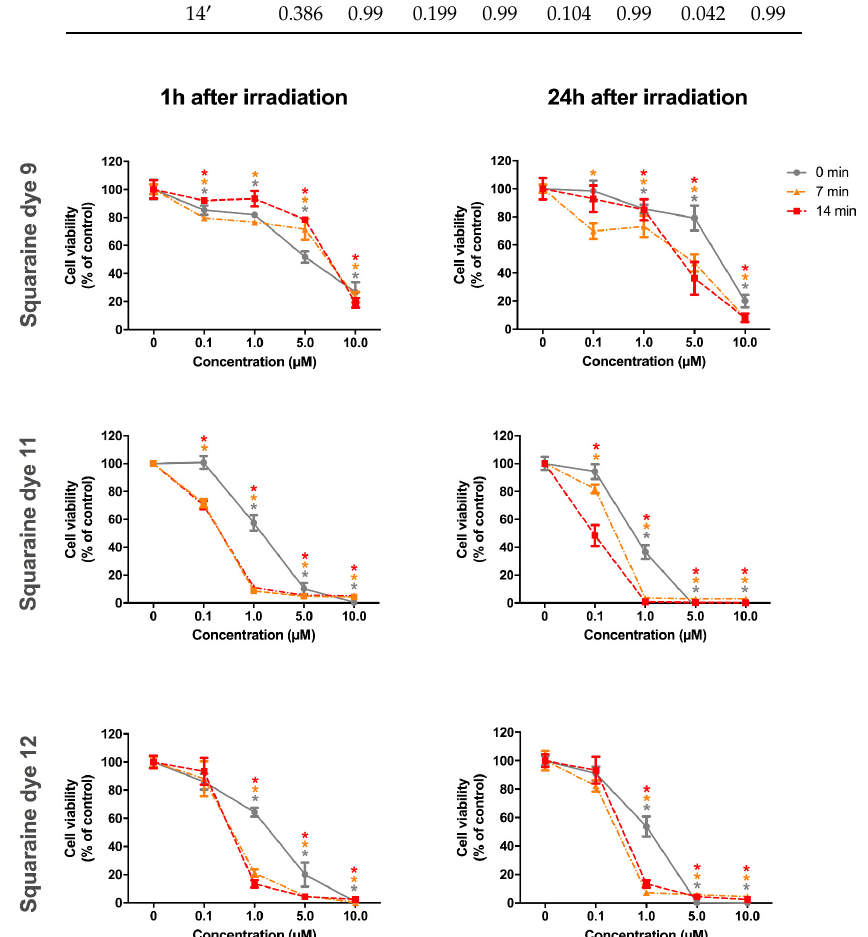
Figure 4. Antiproliferative effects of photodynamic treatment on BT-474 cells. BT-474 cells were exposed for 24 h to the quinoline- and benzoselenazole-derived unsymmetrical squaraine cyanine dyes 9 , 11 and 12 , at indicated concentrations, and then subjected to light-treatment using a light-emitting diode system 0, 7, or 14 min (see methods for details). After contact with the irradiated dyes for 1 h or for 24 h, cell viability was assessed. Cell viabilities are expressed as percentage of control, non-treated cells (0 µ M), and presented as mean value ± standard error of three independent experiments (each one in quadruplicates). Student’s t -test statistical significant treatments related to the non-treated condition ( p -value < 0.05) are evidenced by an asterisk (*) of the color relative to the irradiation